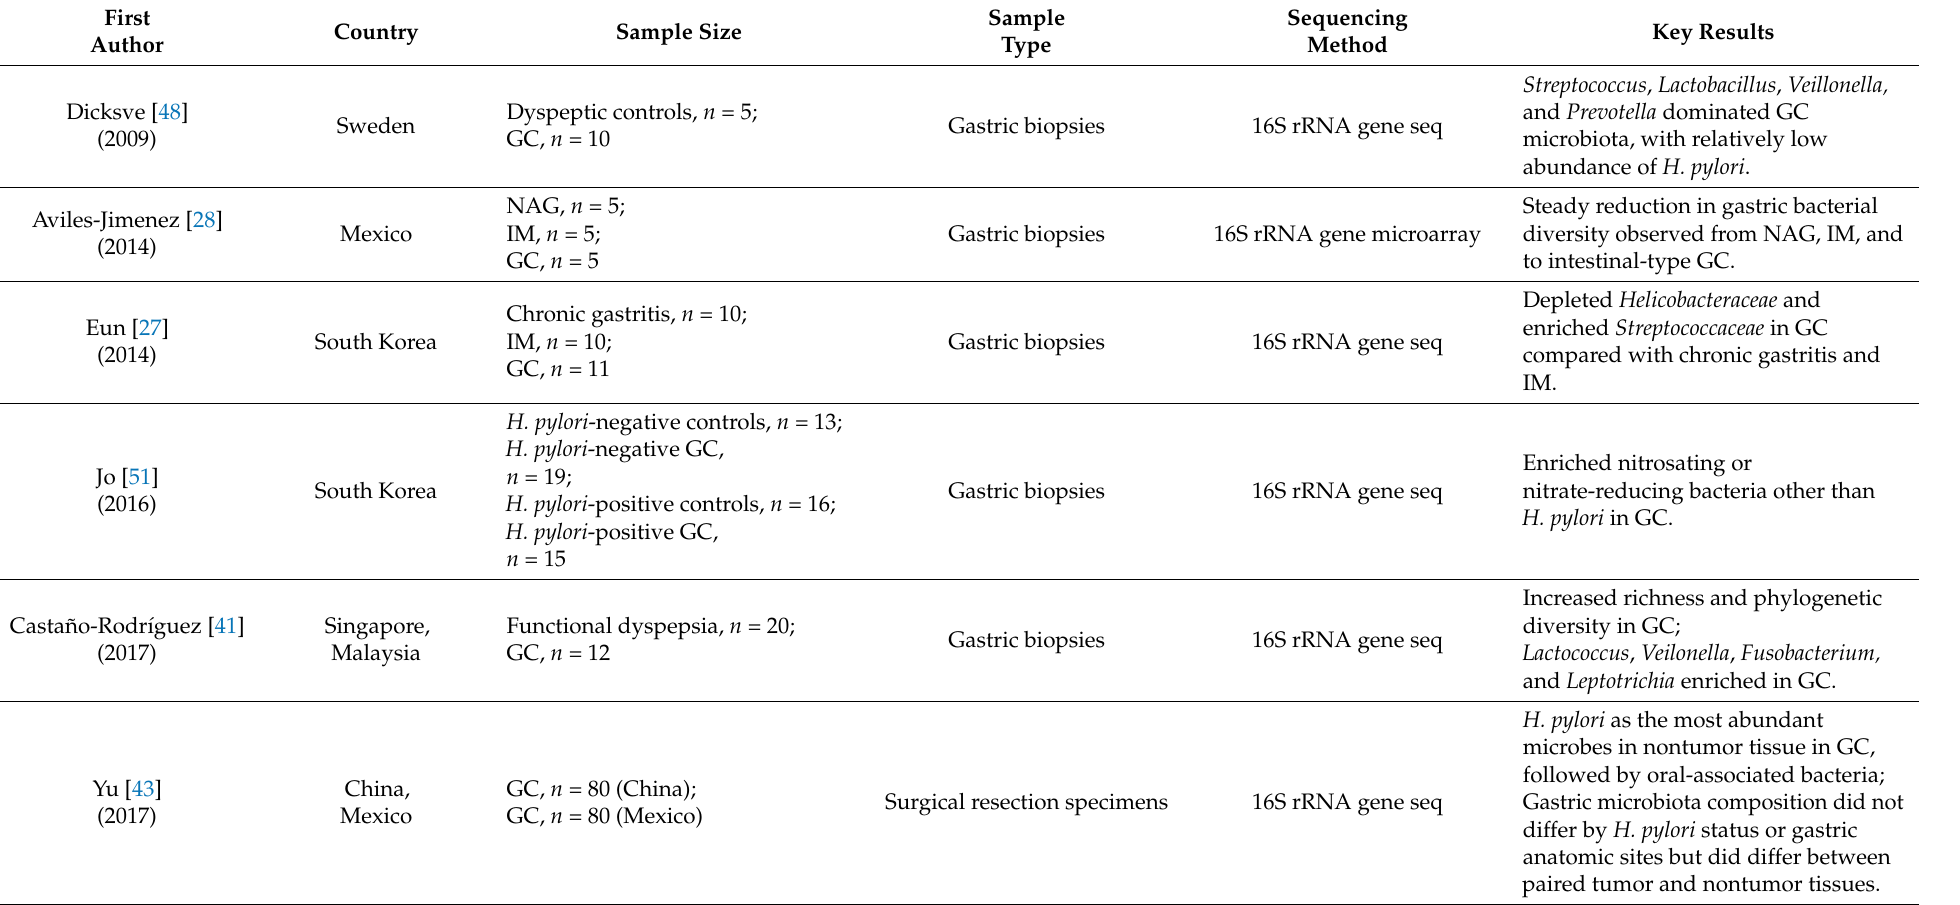
Table 1. Characteristics of sequencing-based studies on human gastric microbiota in gastric